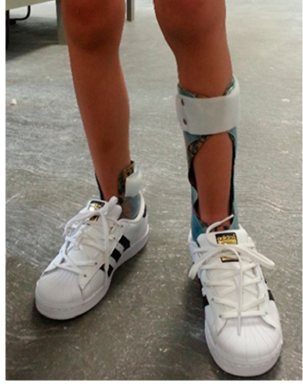
Figure 1. Application of DAFO4 and DAFO Turbo (provides strength and stability, blocking plantar- fl exion and dorsi fl exion) on the patient.